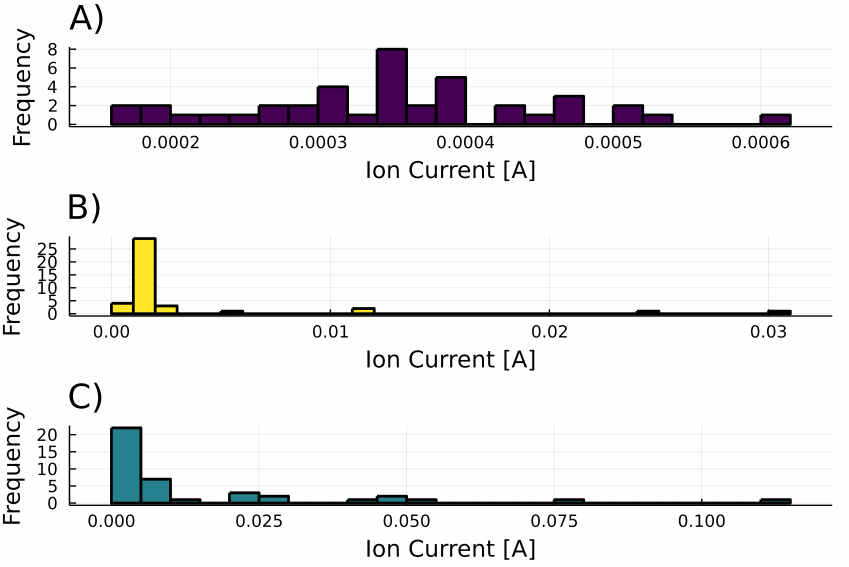
Figure 5. Histograms of the 6-PP ion signal during the experimental time course. ( A ) Arabidopsis thaliana (background, no 6-PP production detected) ( B ) Trichoderma atroviride (constitutive production of 6-PP at low level). ( C ) Interaction between Arabidopsis thaliana and Trichoderma atroviride . Table 1. Time series model of Arabidopsis thaliana interactions with Trichoderma atroviride .